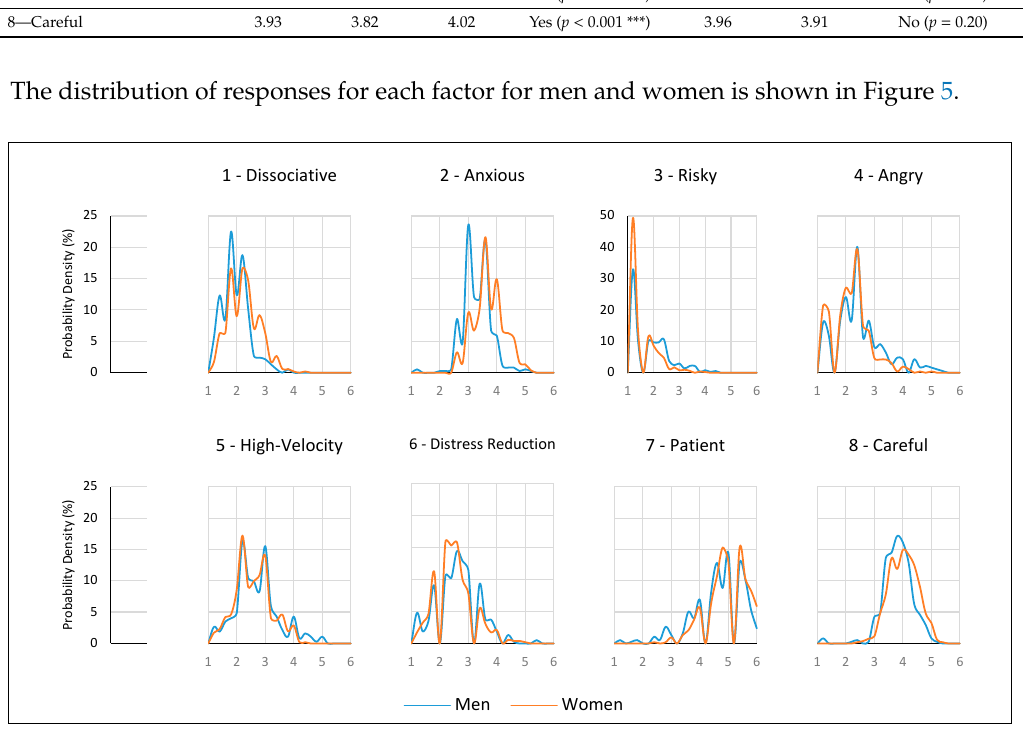
Table 8. Correlation (R) between self-assessment of driving style and willingness to share information. The background indicates the level of correlation between the variables: blue is positive, ochre is negative. Color saturation indicates the magnitude of the correlation.